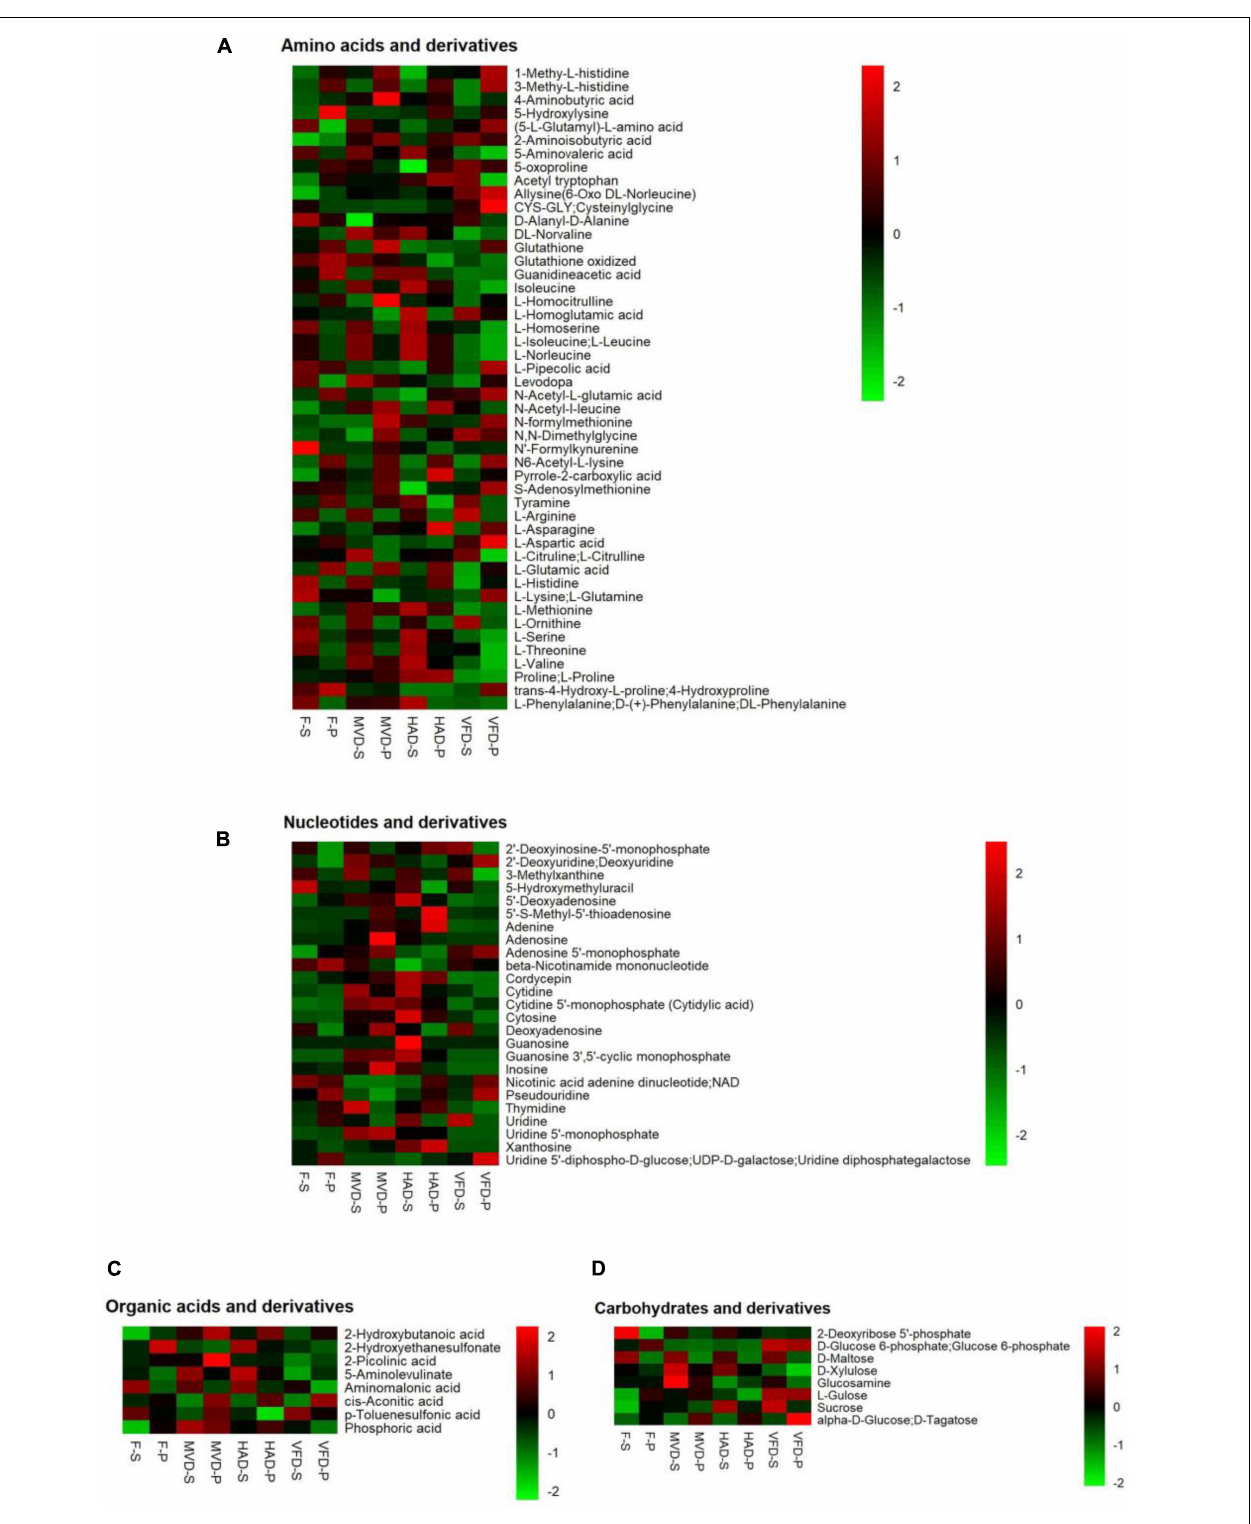
FIGURE 2 | Heat maps of the levels of the non-volatile metabolites under different drying methods. The abscissa represents different experimental groups, the ordinate represents the different metabolites compared by the group. The color indicates the relative expression of metabolites, from low (green) to high (red). (A) Amino acids and their derivatives, (B) nucleotides and their derivatives, (C) organic acid and their derivatives, and (D) carbohydrates and derivatives.